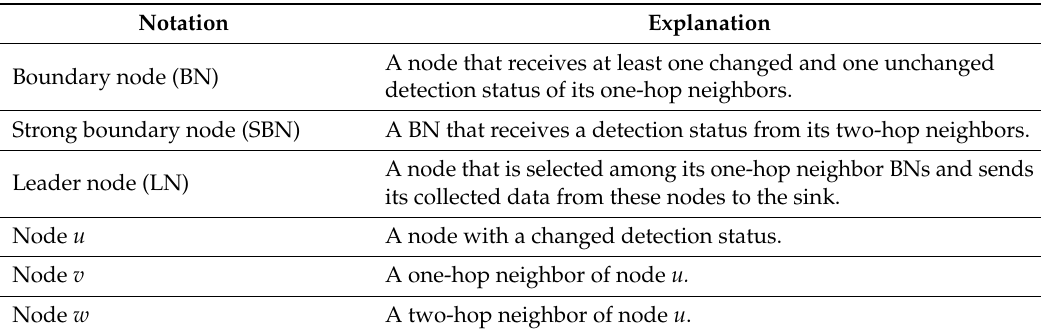
Table 1. Frequently used notations with